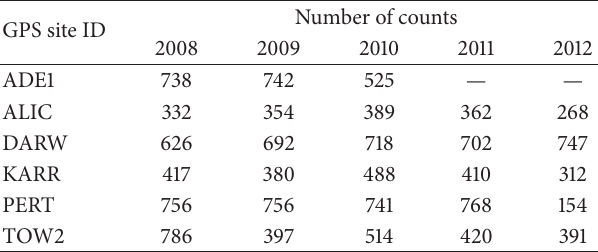
Table 6: Number of counts used to compare between GPS-PWV and